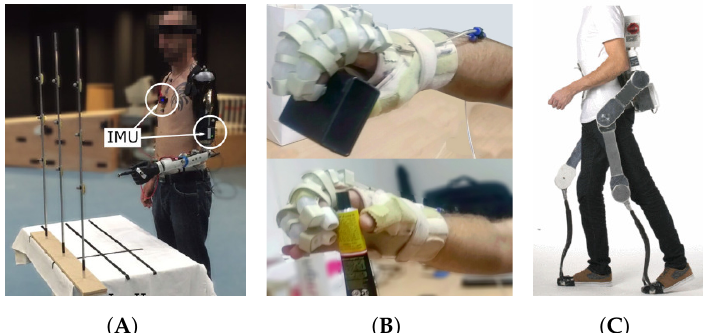
Figure 1. Wearable assistive robots such as ( A ) prosthetics [5] (Licensed under (CC BY 4.0)), ( B ) or- thotics [6]) (Reproduced with permission from Elsevier) and ( C ) exoskeletons [8] (Licensed under (CC BY 4.0)), can help users to restore weak limb functions and substitute lost